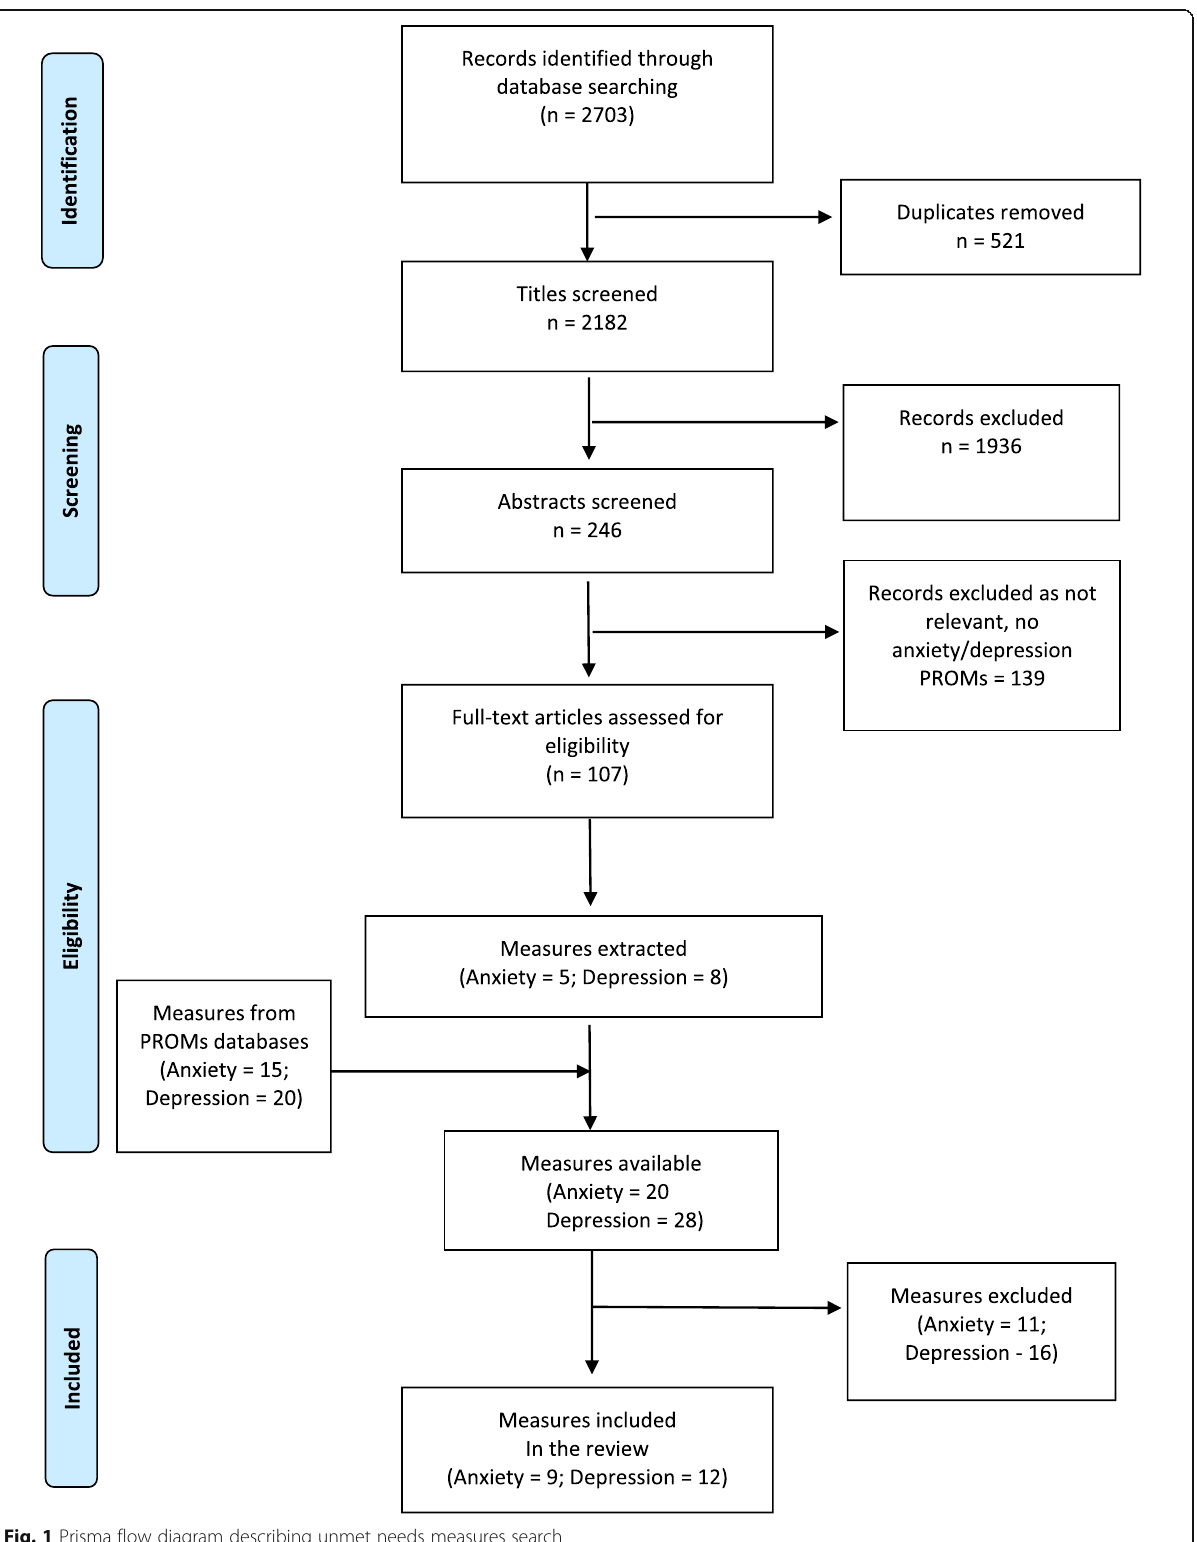
Fig. 1 Prisma flow diagram describing unmet needs measures